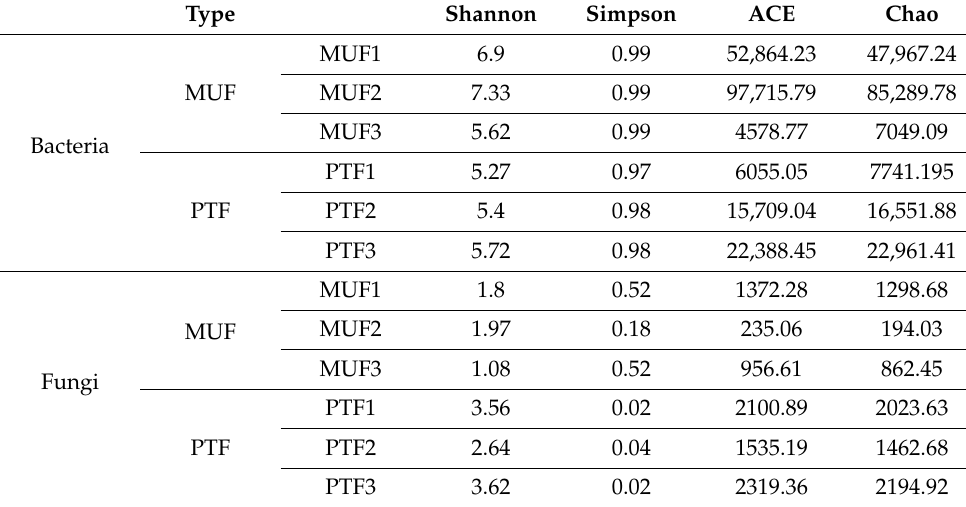
Table 3. Alpha diversity of bacterial communities in each sampling